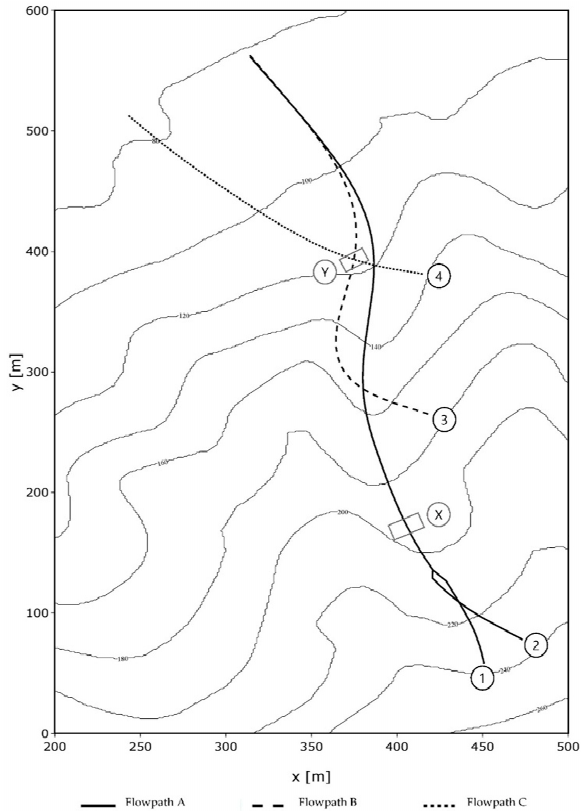
Figure 14. The hazard assessment map generated from the developed framework showing the different flowpaths that originated from the four sources indicated by circled numbers. The rectangles show the locations of proposed potential closed-type barriers for mitigation against the debris-flow.